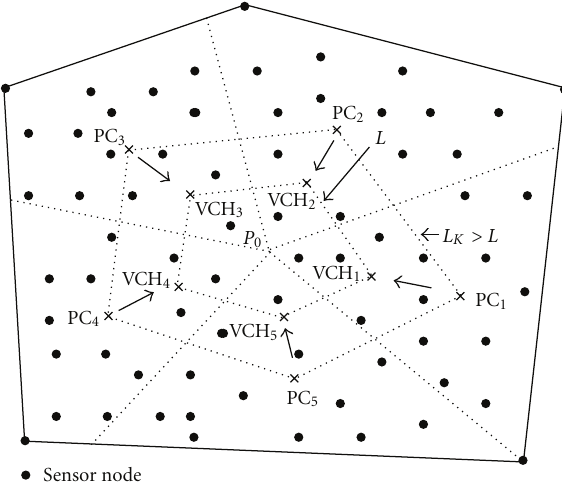
Figure 1: An illustrative example of virtual cluster heads calcula- tion, for K = 5 clusters. PC i and VCH i , 1 ≤ i ≤ K are the locations of clusters’ area centre points and virtual cluster heads, respectively. L is the length of the BS tour required, and L K is the BS tour length connecting PC i